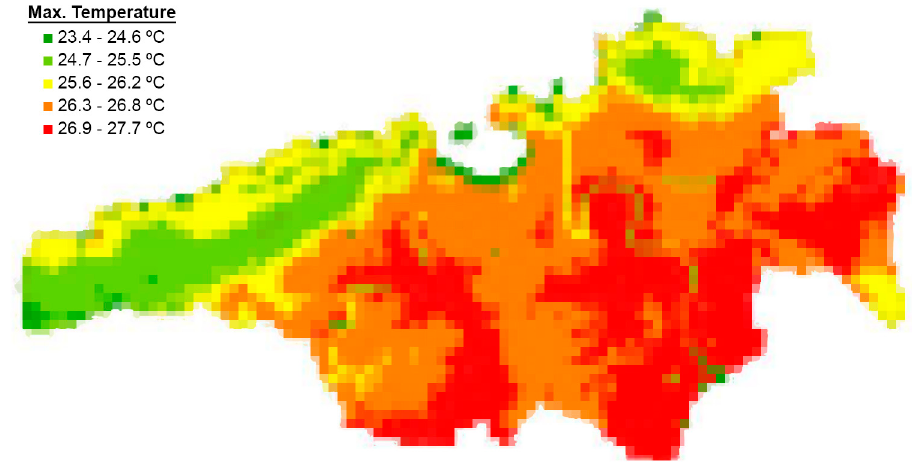
Figure 16. Map of maximum mean temperatures from the UrbClim study, measured in the period May to September 2003 with a resolution of 100 m. Source: UrbClim Donostia-San Sebastian [91].